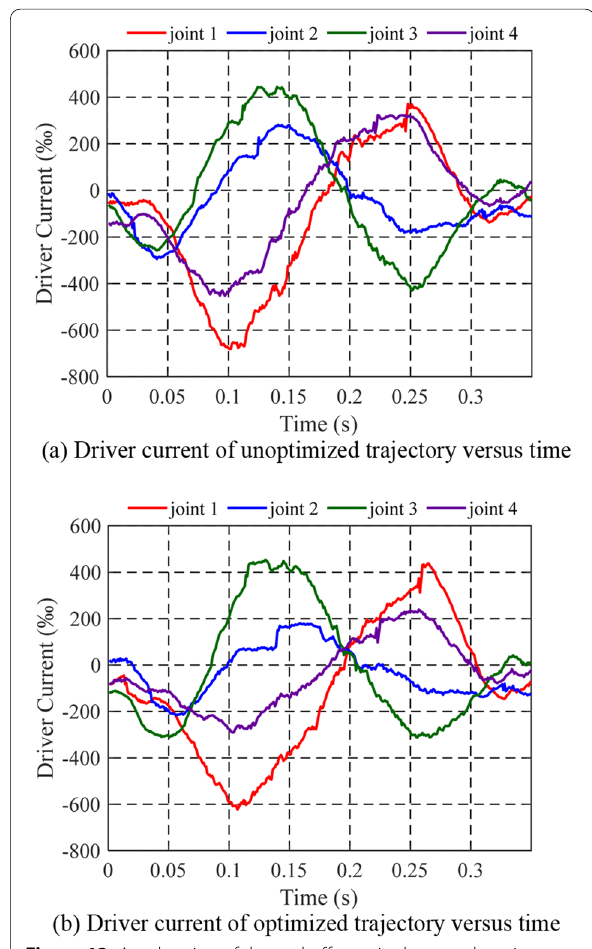
Figure 13 Acceleration of the end-effector in the x- and y -axis